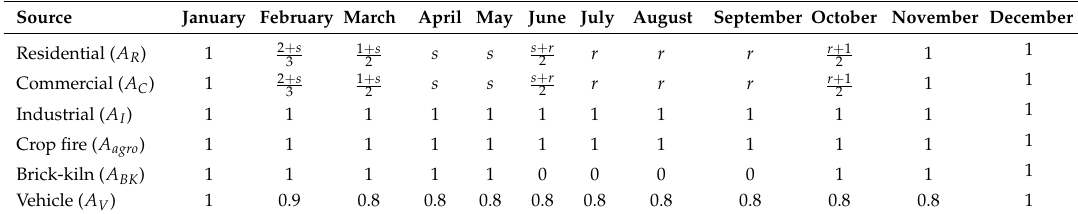
Table 2. Assumed monthly distribution of seasonal activity parameters ( SEA mon ). s , r represent values of seasonal activity for summer and rain season respectively. For any source SEA mon represents ratio of emissions in any month mon compared to its maximum monthly